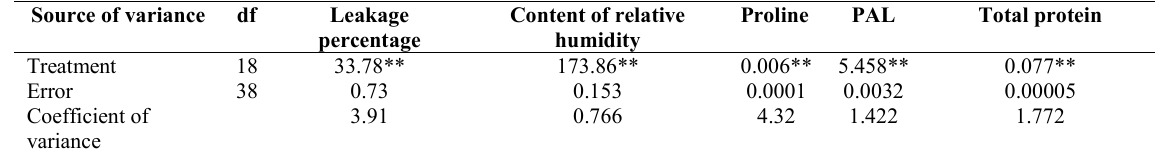
Table 3 . Variance analysis of biochemical properties in samples treated by EMS based on randomized enzyme. Source of